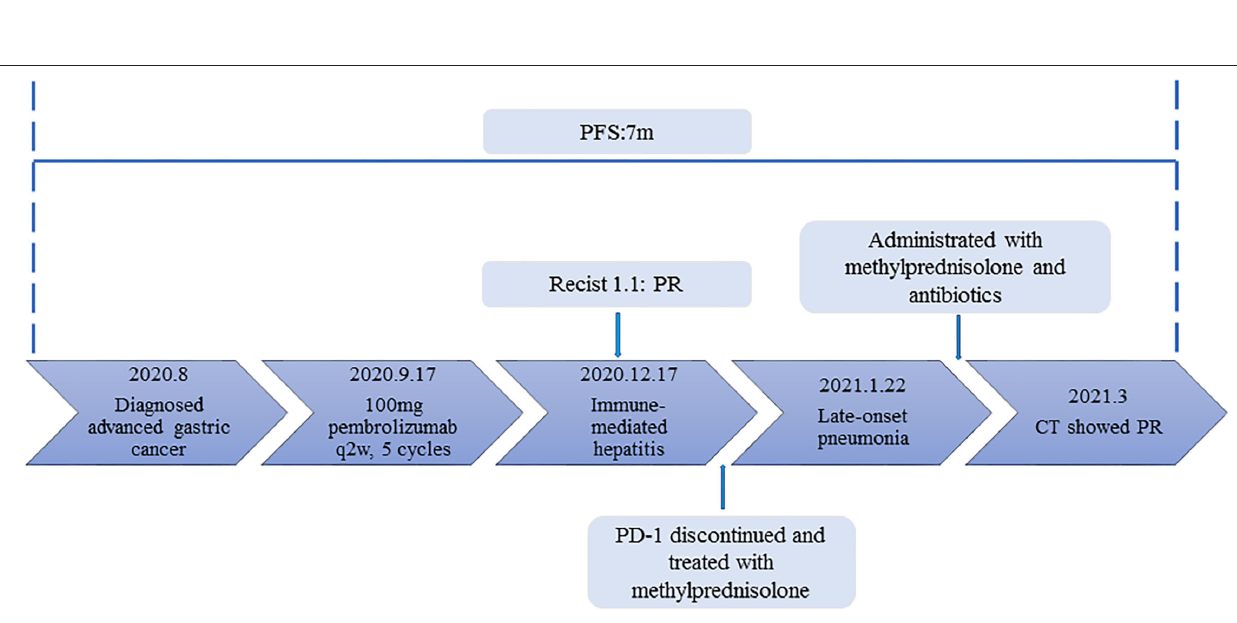
Frontiers in Medicine | www.frontiersin.org